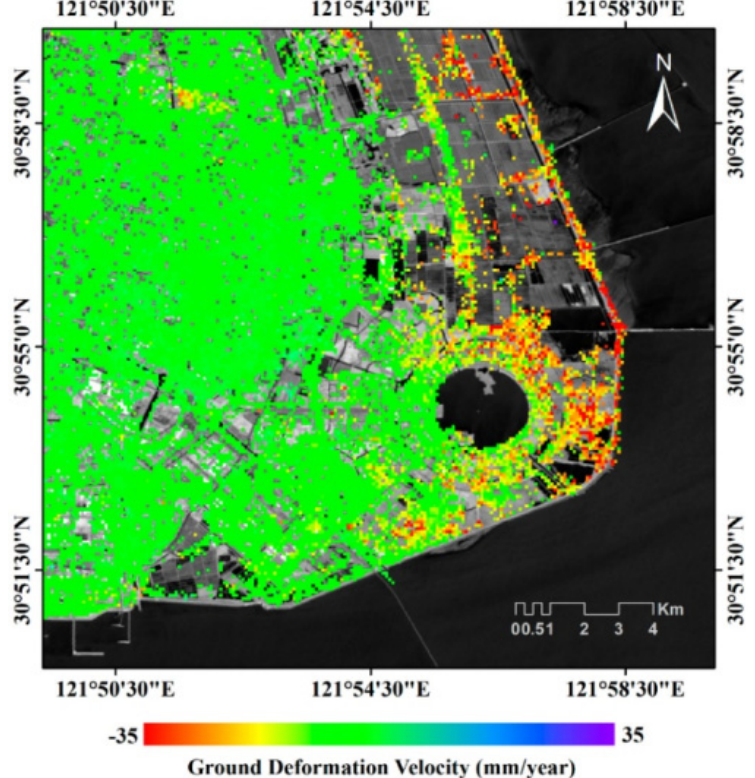
Figure 4. Map of the mean (vertical) deformation velocity from 2007 to 2016 Lingang New City of Shanghai, as retrieved by combining the time-gapped ENV and CSK LOS displacement time-series (refer to [16]).